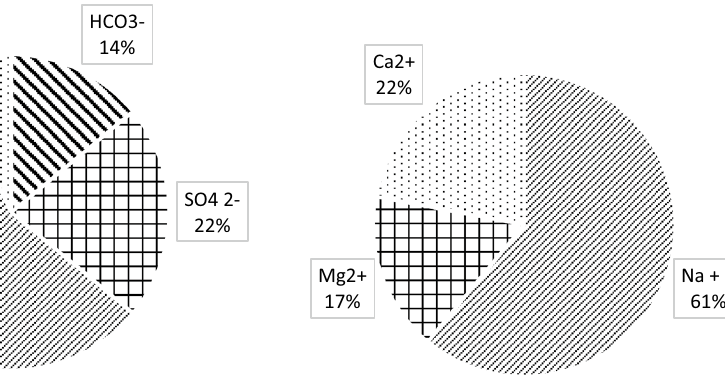
Fig. 3 Pie diagram of median values of major